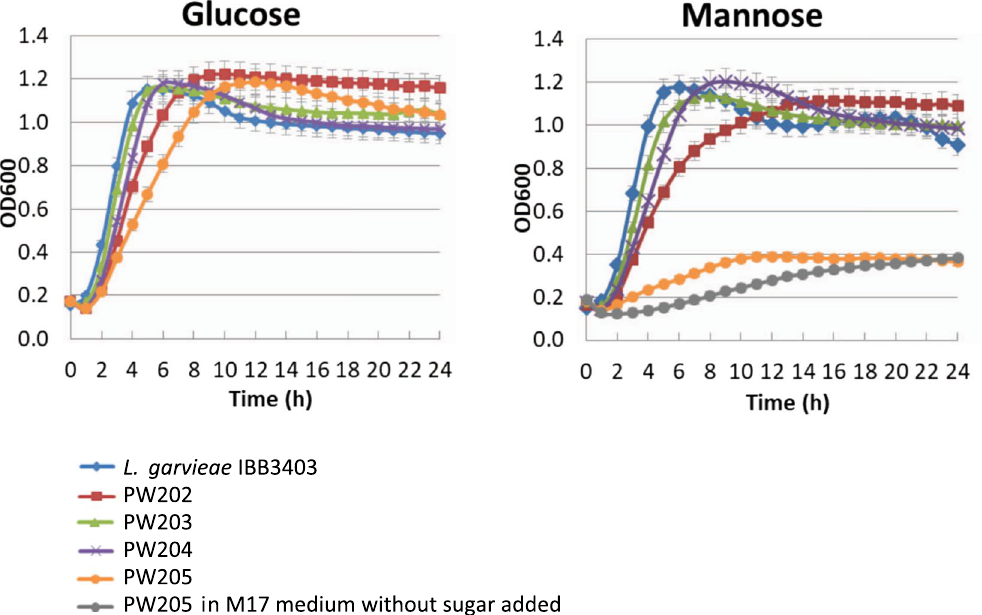
Figure 5. Growth of wild-type L . garvieae IBB3403 and L . garvieae IBB3403 spontaneous mutants resistant to GarQ in M17 medium supplemented with glucose or mannose. PW202 carries Pro100 → His substitution in subunit IIC, PW203 Thr123 → Ile substitution in IID, PW204 Pro111 → Ser substitution in IID and PW205 nonsense mutation in IID. As a control growth of PW205 in M17 medium without sugar added is shown. Data are presented as mean ± SD (n =